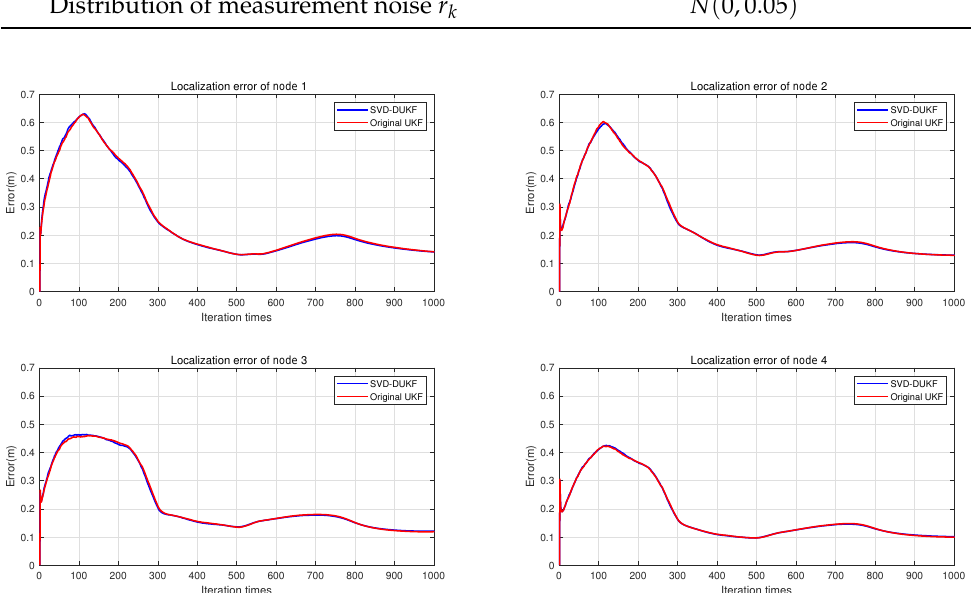
Figure 4. Average localization errors of 4 nodes in 1500 Monte Carlo trials. The red line represents the RO localization based on the original UKF, and the blue line represents the RO localization based on